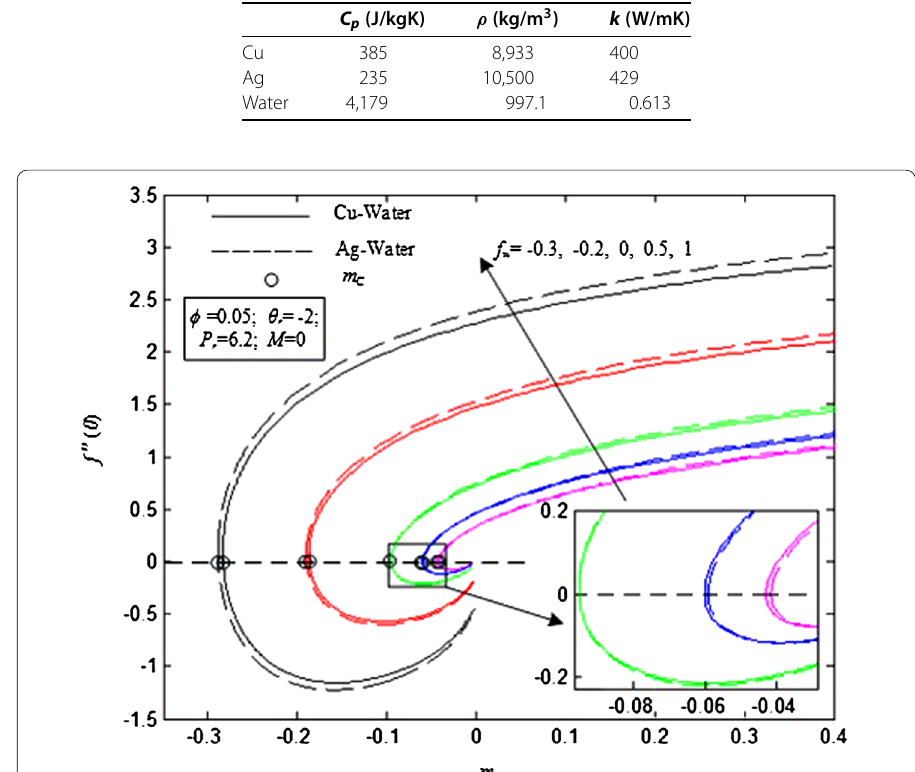
Figure 2 Skin friction coefficient as a function of m for representative values of f w